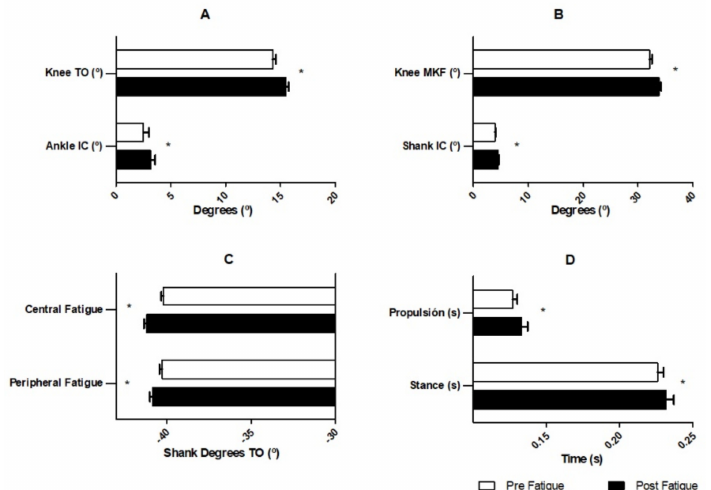
Figure 3. Statistical differences between pre and post fatigue protocols. ( A ): Kinematics differences after peripheral fatigue protocol; ( B ): kinematic differences after central fatigue protocol; ( C ): shank differences after central and peripheral fatigue protocols; ( D ): spatiotemporal differences after the central fatigue protocol. *: Statistically differences ( p < 0.05) between pre and post